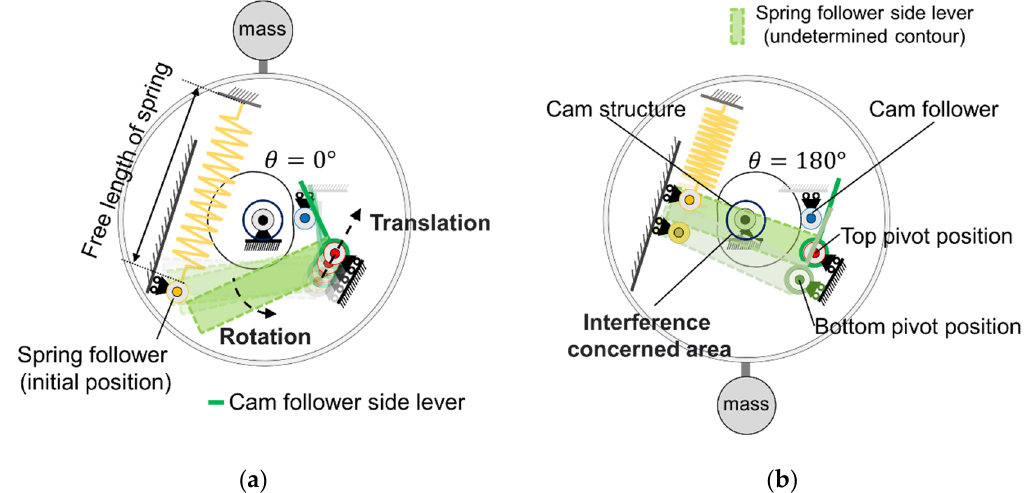
Figure 4. Functional requirements of the lever for CVGC: ( a ) The translation and rotation of the lever when the pivot position changes; ( b ) the maximum compressions of the spring at each top pivot position and bottom pivot position. Interference can occur between the lever and cam structure.